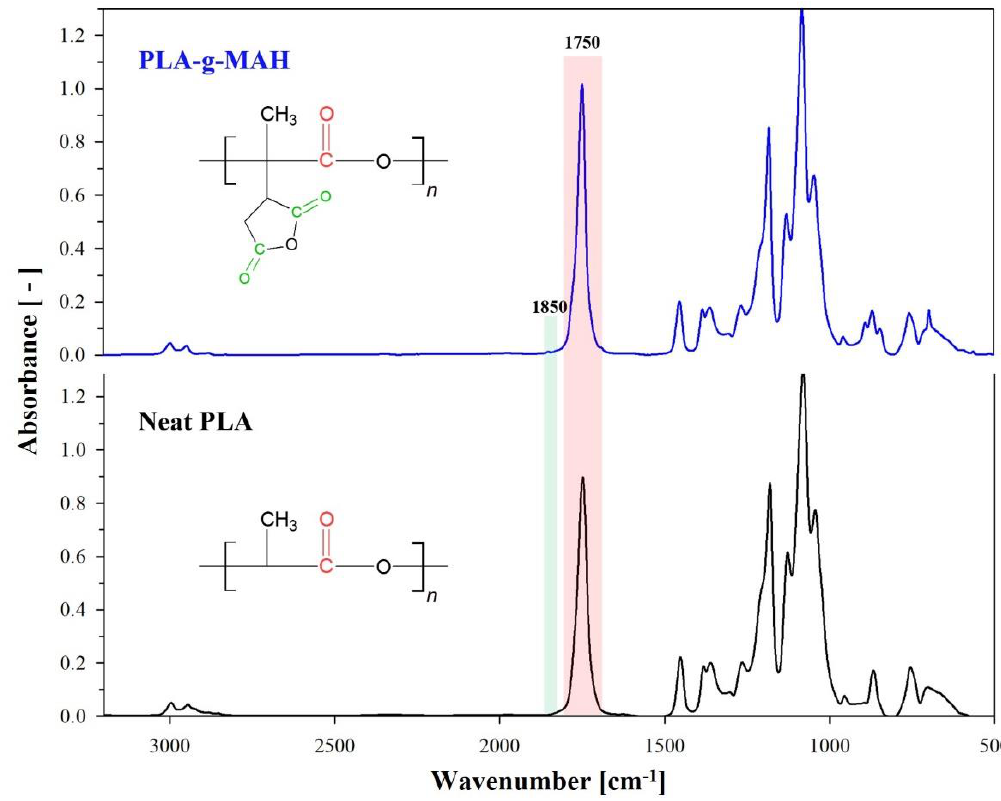
Figure 1. FT-IR spectrum of neat PLA and PLA-g-MAH with 1 phr DCP and 6 phr MAH.